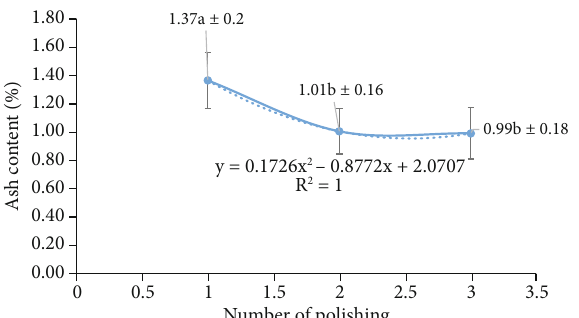
Figure 19: Carbohydrate content (by di ff erence) of three varieties of polished